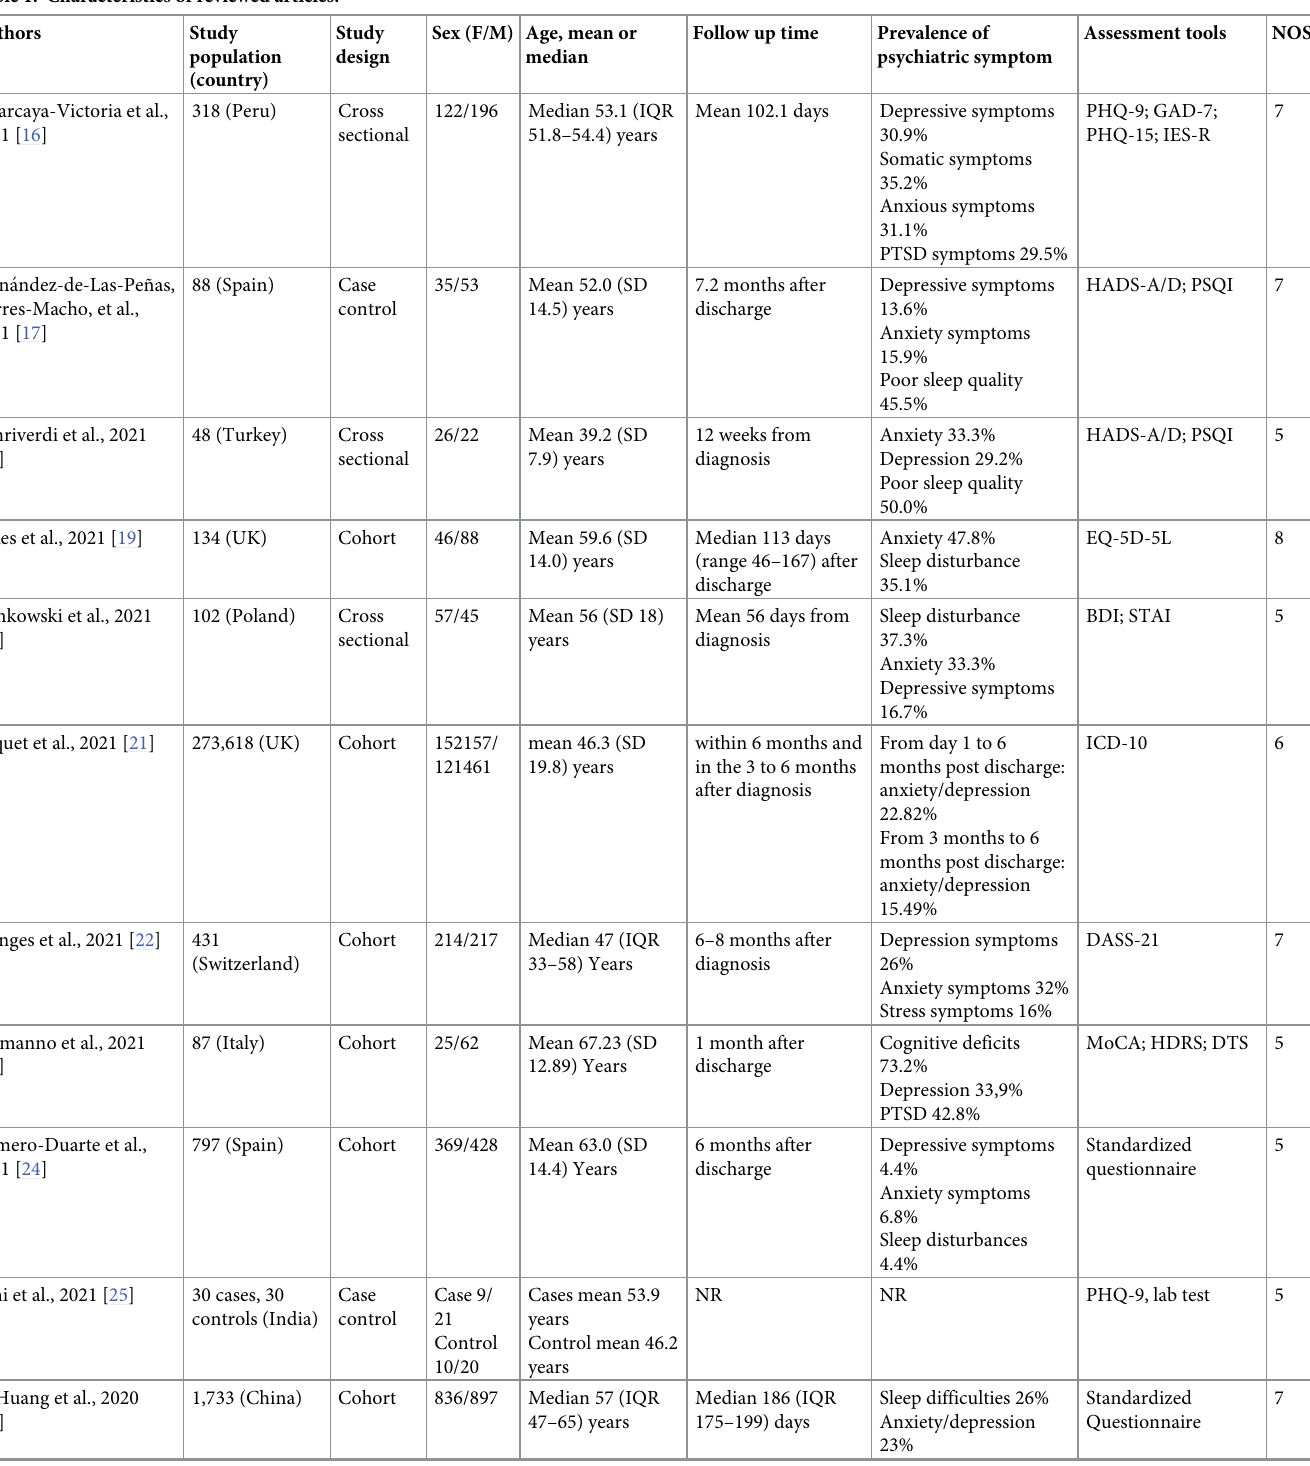
Table 1. Characteristics of reviewed